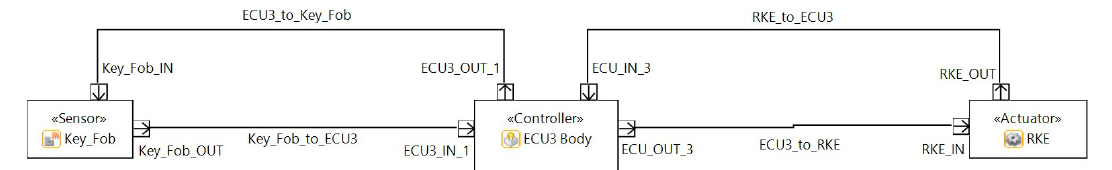
Figure 8. Realization of ECU3 Traditional Architecture in Ansys Medini Analyze.